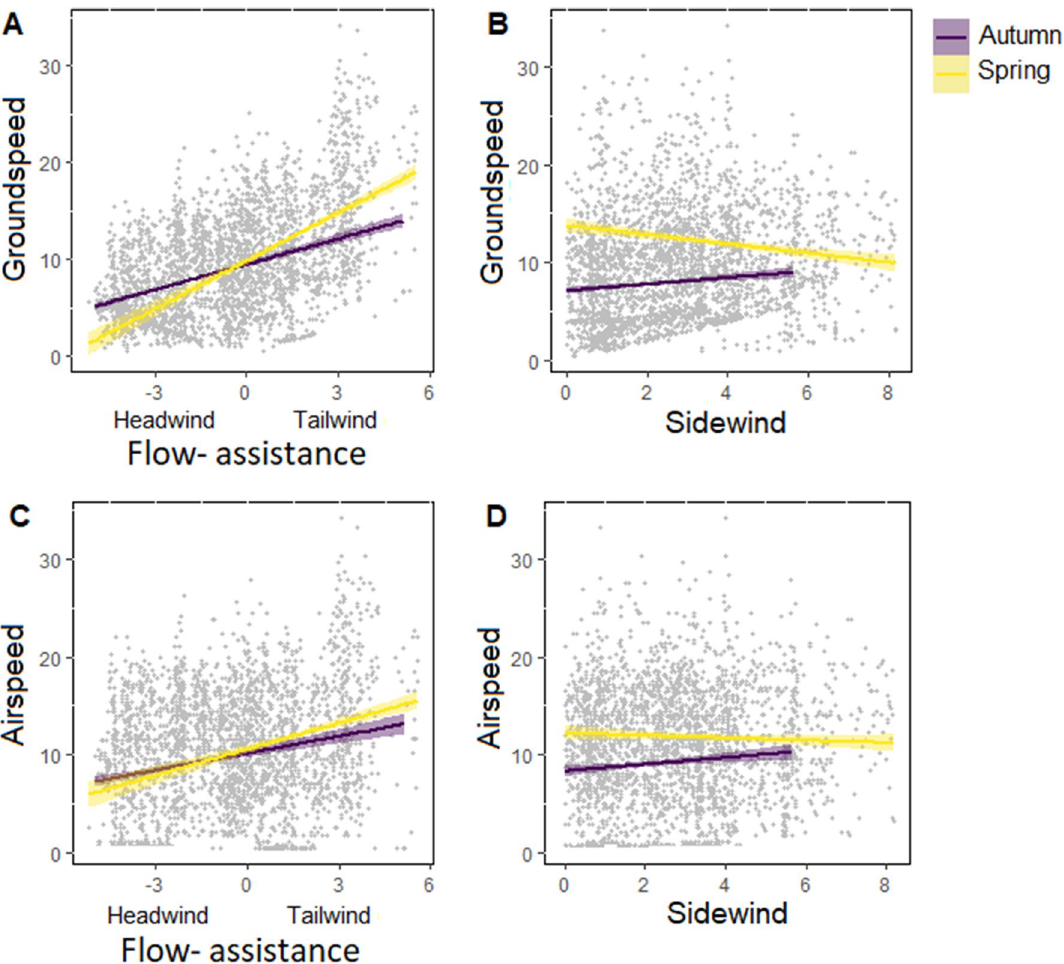
Figure 6. Black Kites groundspeed and airspeed fitted with linear regression lines (colorful lines, with 95% CI as the same colour area) in relation to sidewind and flow-assistance during the autumn/post-breeding (purple) and spring/pre-breeding (yellow) crossing over the